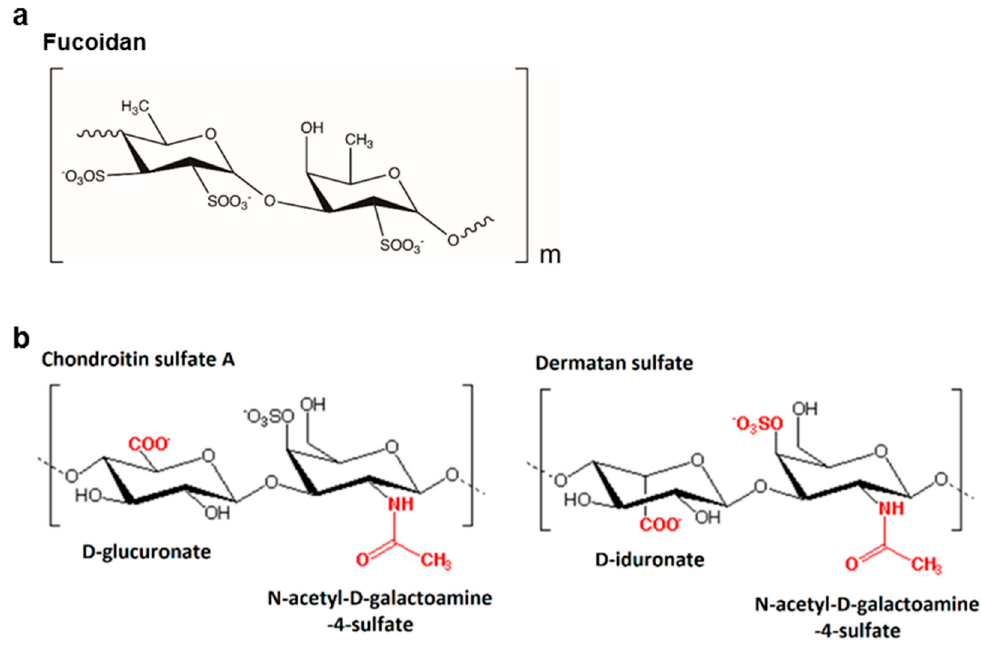
Figure 2. ( a ) Chemical structure of fucoidan and ( b ) chemical structures of chondroitin sulfate A (chondroitin-4-sulfate) and dermatan sulfate highlighting the position of functional groups in red. For EIS measurements, the incubation of GAGs with the Lcl-modified gold electrode surfaces allowed the attachment of GAGs to the